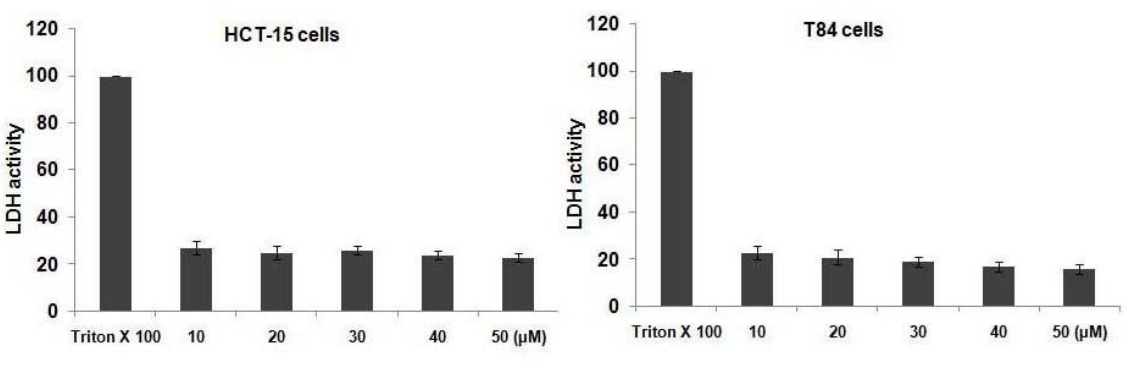
Figure 2: Trolox treatment exhibits no significant effect on the secretion of LDH into the medium in colon cancer cell lines. The values were compared to triton X